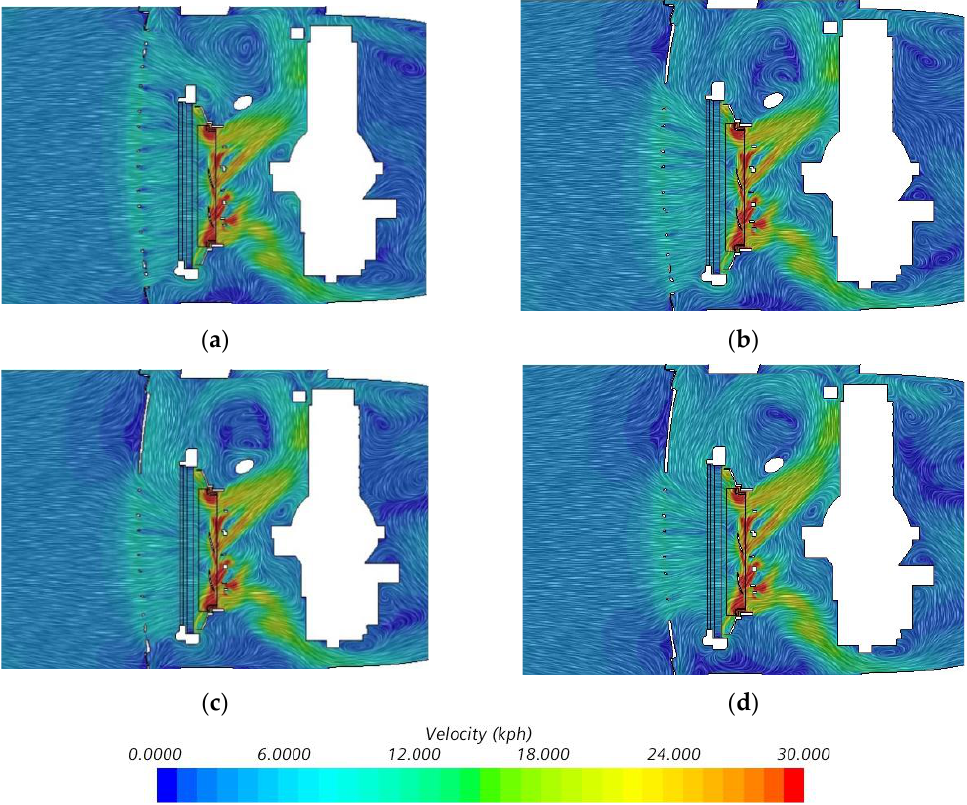
Figure 26. Velocity fields of z = 0.08 m section under different lower grille closure schemes: ( a ) original vehicle; ( b ) scheme 1; ( c ) scheme 2; ( d ) scheme 3.